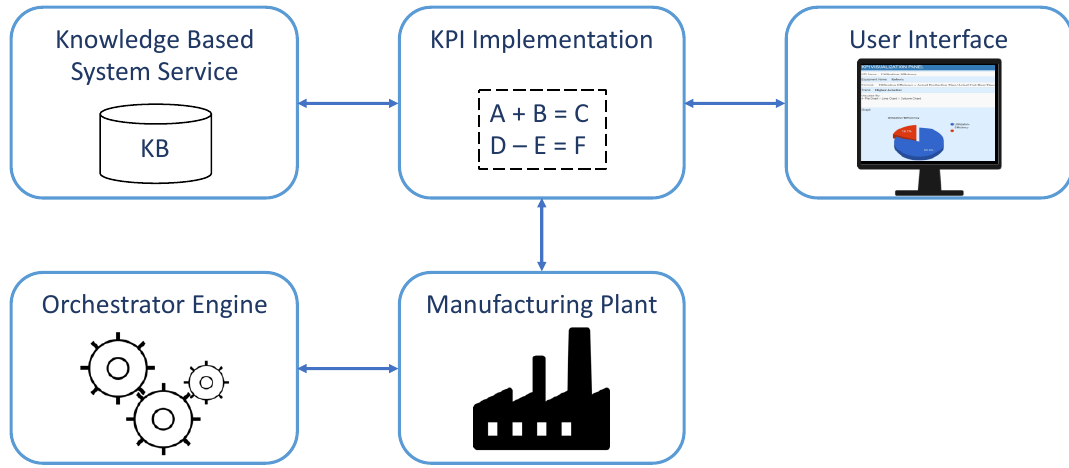
Figure 2. The five main components of the approach.